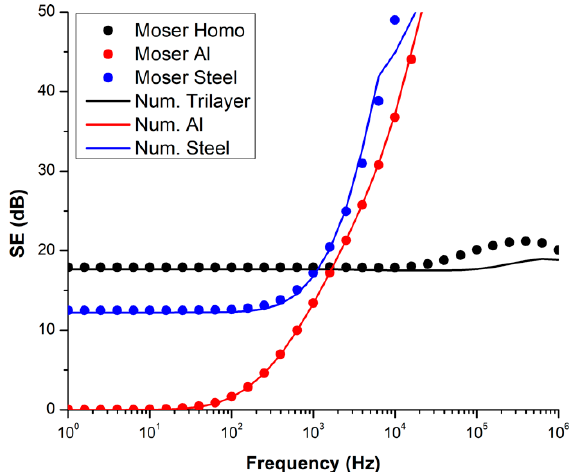
Figure 11. Shielding effectiveness at iso ‐ mass obtained with the Moser model (dot) and numerically (line) of the trilayer composite (black), the aluminum layer (red), and the steel layer (blue). The SE calculated with the Moser model and numerically are close for both Al and steel layers. As the steel is magnetic, a slight difference, less than 0.3 dB, is observed at a